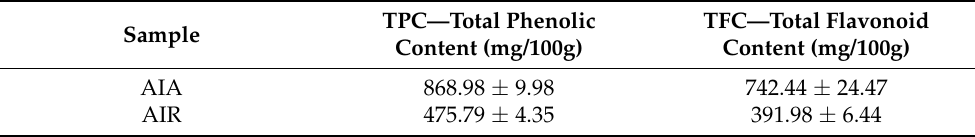
Table 2. Total phenol content and total flavonoid content for the sample extracts.